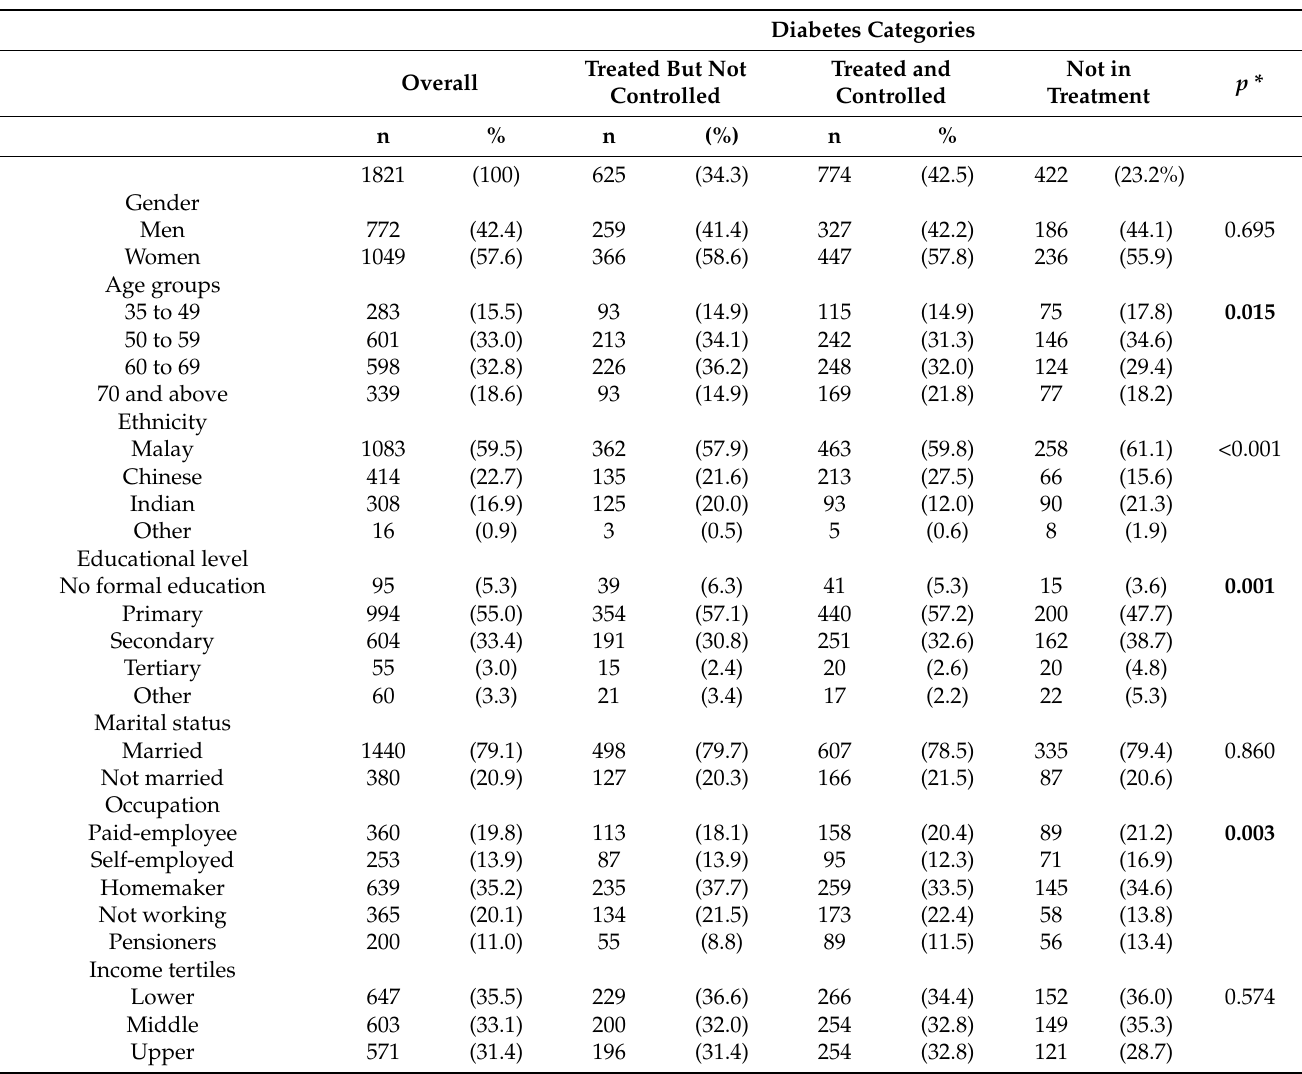
Table 1. Sociodemographic characteristics of study participants by diabetes status (N = 1821). Diabetes